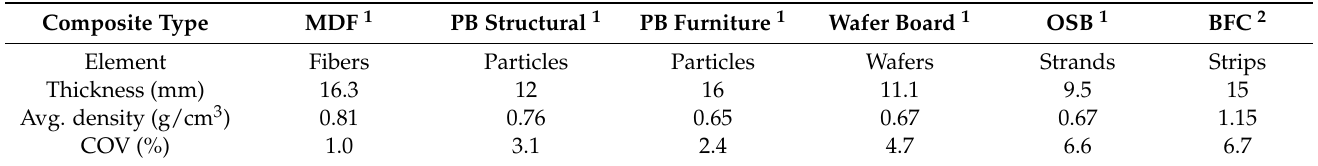
Table 2. Comparison of density variation of different commercial panel types.